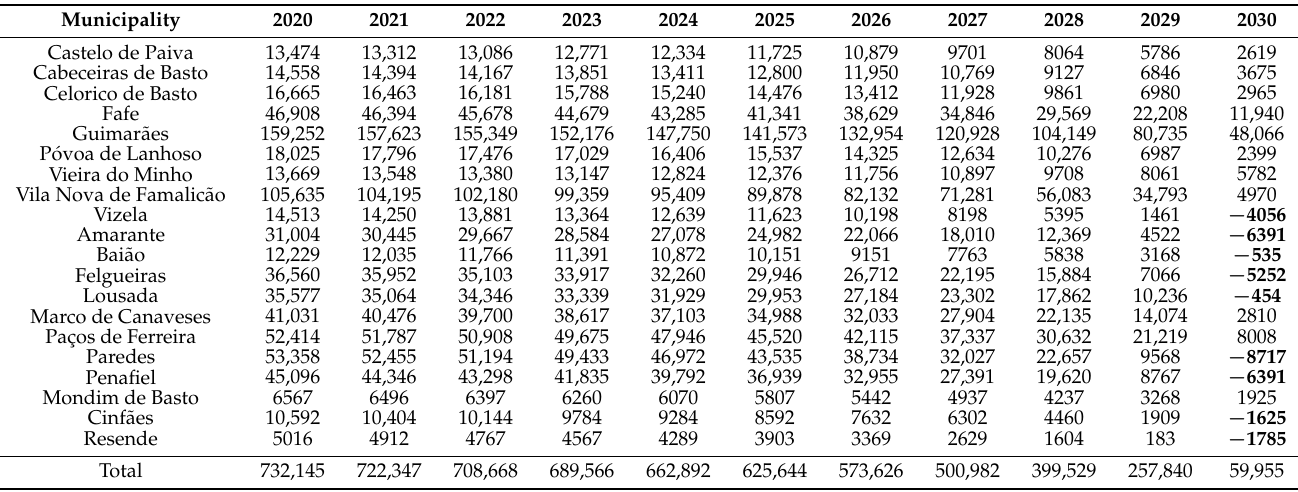
Table A4. Scenario 2: Impacts (available power–required power) of the BEV fleet on the grid during peak hours (values in kVA).